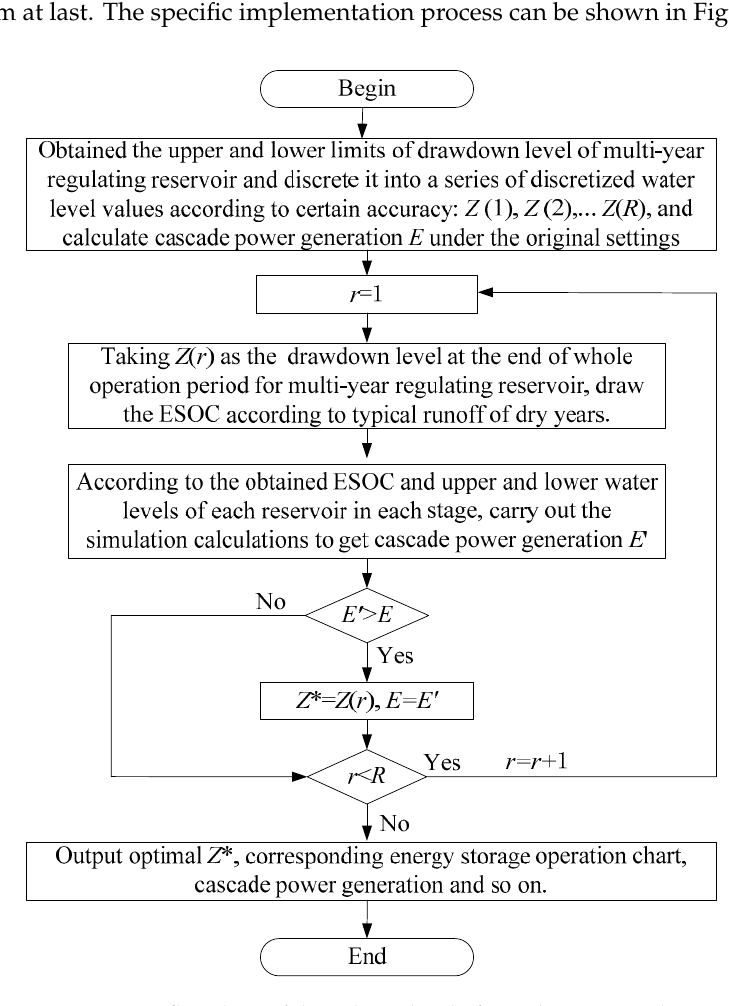
Figure 6. Optimization flowchart of drawdown level of a multi-year regulating reservoir.